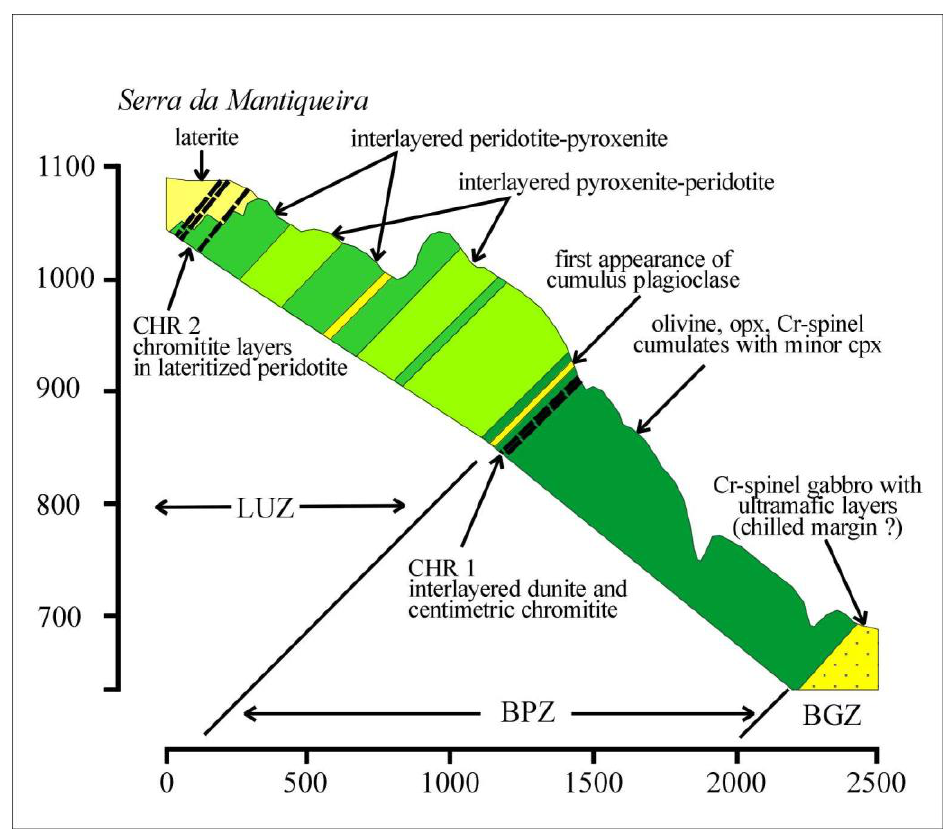
Figure 2. Geologic profile W – E showing stratigraphic location of the two chromitite horizons CHR-1 and CHR-2; Note that the upper chromitite CHR-2 occurs within the laterite cover in the highland of Serra da Mantiqueira. (Vertical and horizontal scale are in